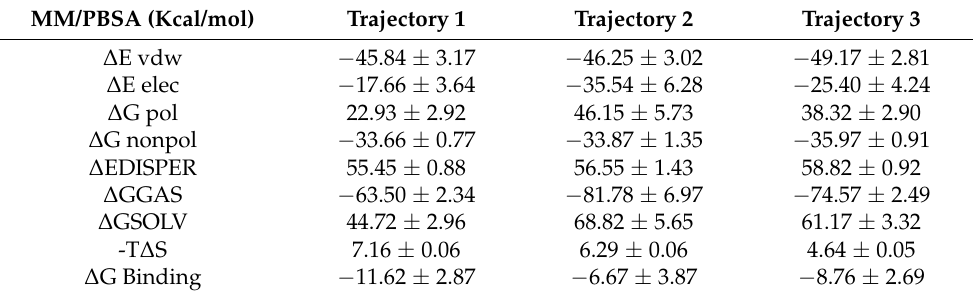
Table 5. Gibbs binding free energy (kcal/mol) of pS273R − E64 calculated by MM/PBSA.